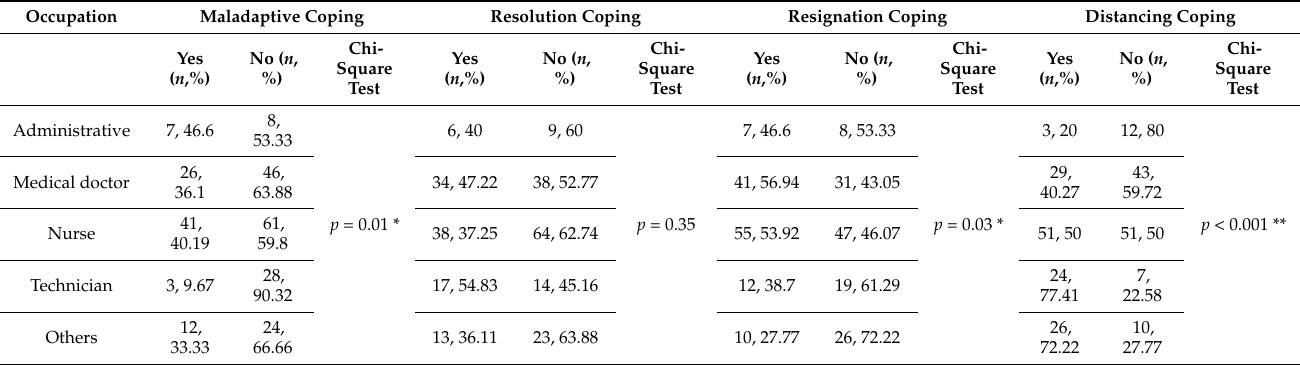
Figure 3. Box and whiskers graph, age, and stress diagnosis. 1 women, 0 men, * p < 0.05 As for coping strategies, distancing coping was the most common with 133 (51.95%) subjects, 73 (54.88%) males and 60 females (45.11%) ( p = 0.32). The second most common was resignation with 125 (48.82%) subjects, 75 (60%) males and 50 (40%) females ( p = 0.12), followed by resolution coping mechanism, present in 108 (42.18%) subjects, 53 (49.07%) males and 55 (50.92%) females ( p = 0.45). Finally, the least common coping mechanism was maladaptive coping, with 90 (35.15%) subjects, 55 (61.11%) males and 35 (38.88%) females ( p = 0.03). The distribution of coping strategies by occupation can be seen in Table 3. Table 3. Distribution of coping strategies by occupation.